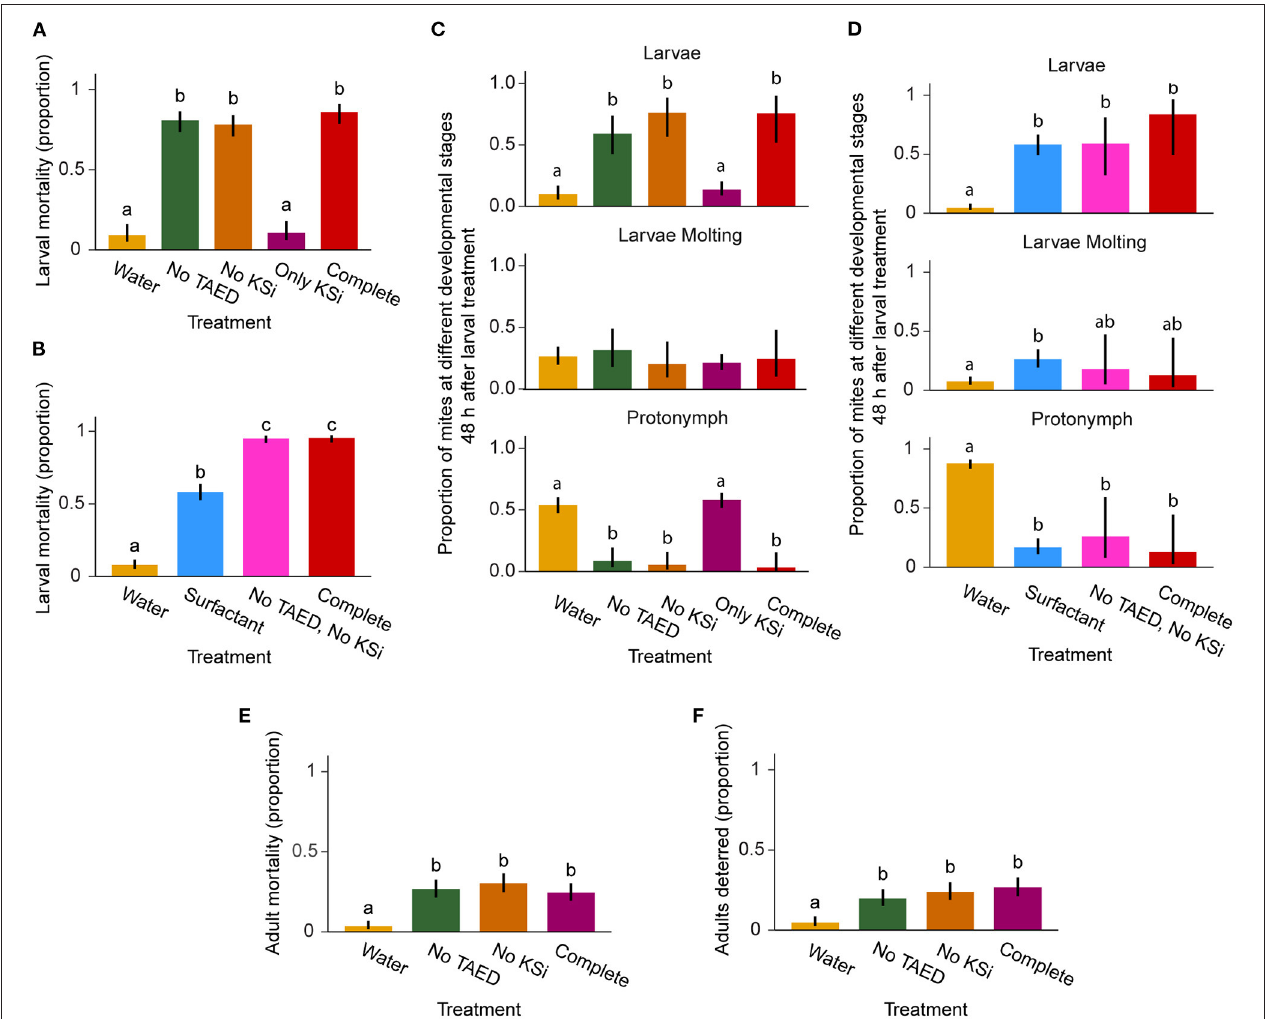
FIGURE 3 | Effects of Neo-Boost components on larvae and adults at 48 hours post-treatment. (A, B) Larval mortality ( n = 60/treatment). (C, D) Proportions of different mite developmental stages following larval treatment [ n = 27–59/treatment, depending on number of samples with surviving mites from (A) and (B) ]. (E) Adult mortality ( n = 60/treatment). (F) Adult deterrence ( n = 60/treatment). Shown are proportions of dead mites, developmental stage, and deterrence ± 95% confidence interval (CI). Letters within graphs represent differences between pairwise comparisons of means by Tukey’s HSD ( P <